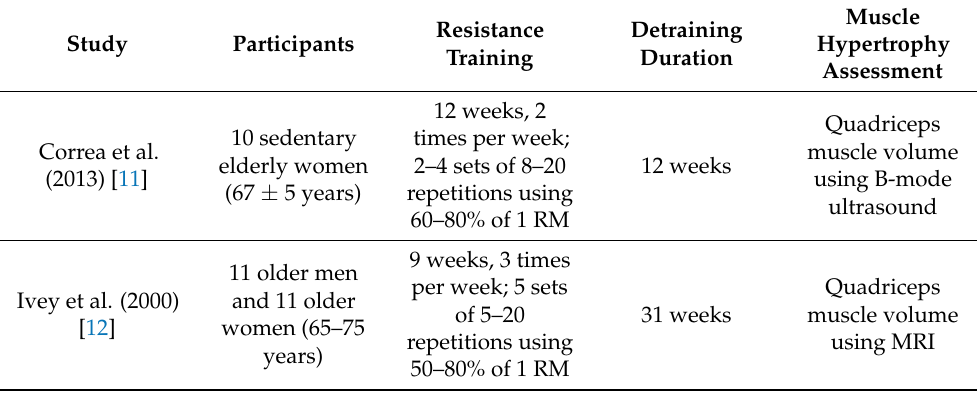
Table 1. Summary of the included studies.